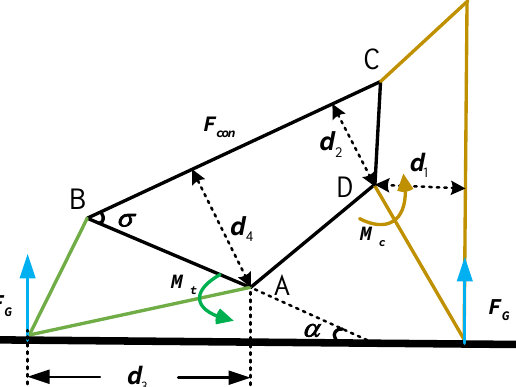
Figure 7. The state of the bionic mechanism when the foot lands on the ground. F G is the support from the ground. F con indicates the internal force of the connecting rod. M t denotes the moment of the touchdown rod with respect to point A defined in Figure 6; M c denotes the moment of the claw with respect to point D. α is the angle between the touchdown rod and the horizontal line. σ is ∠ ABC. d 1 and d 3 are the distances from D and A to the extension of force F G , respectively. d 2 and d 4 are the distances from D and A to the connecting rod CD, respectively.